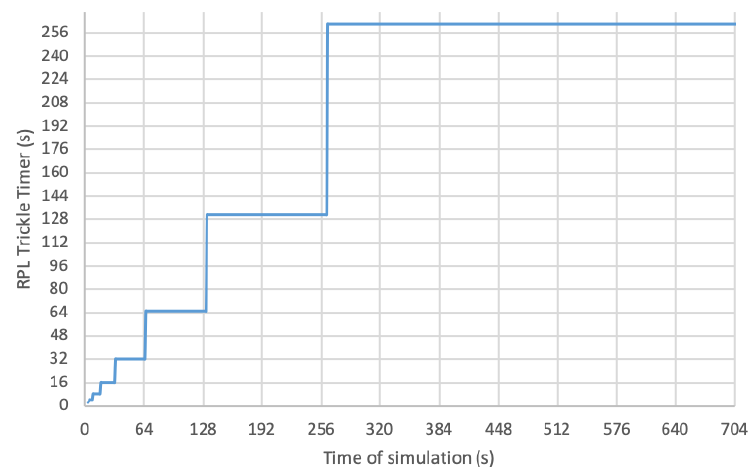
Figure 2. RPL Trickle Timer evolution in time for I min = 4 s and Doublings times =